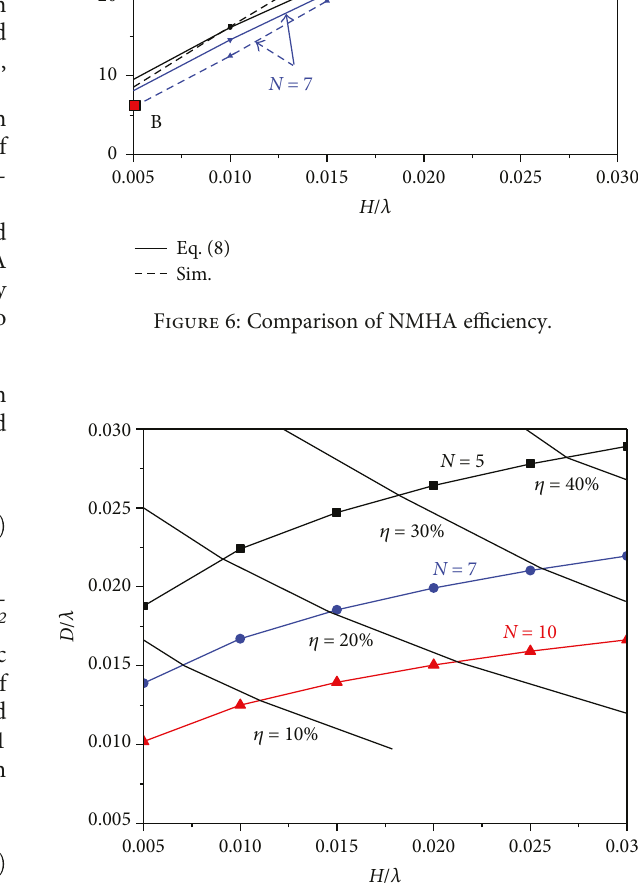
Figure 7: Relationship between the antenna structures and antenna e ffi ciency of